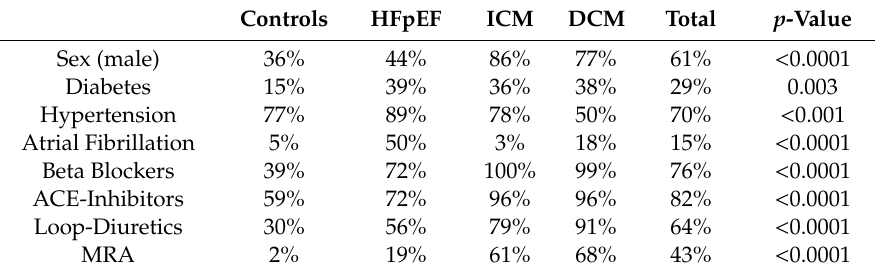
Table 2. Concomitant diseases and